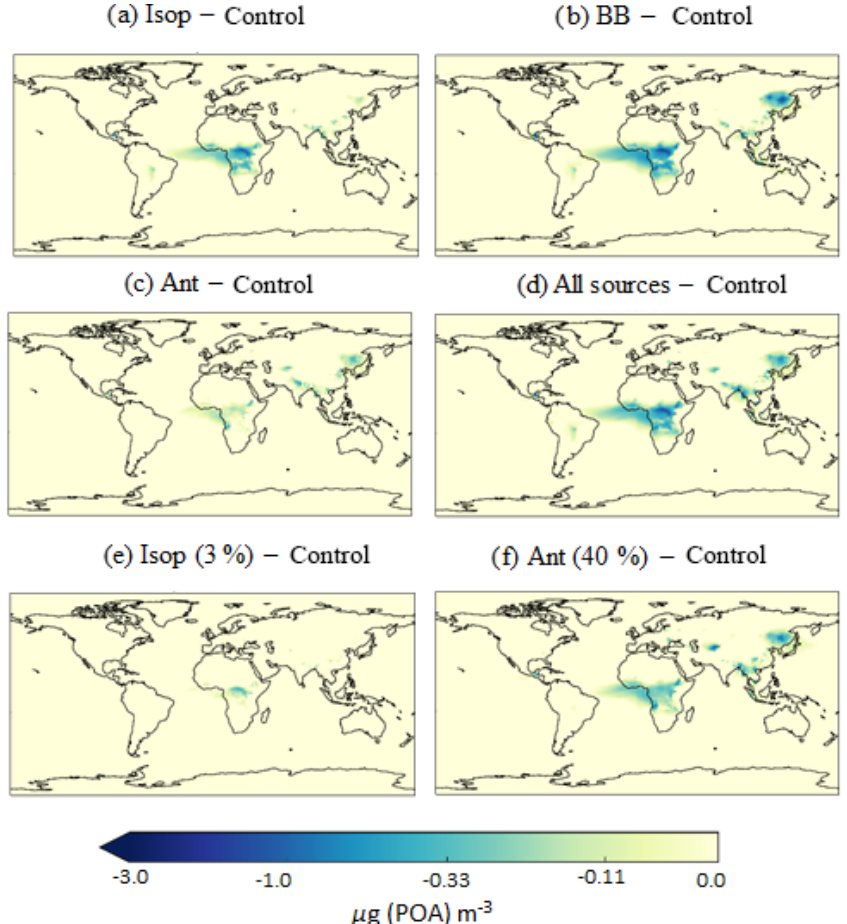
Figure 9. Differences in annual average surface total POA concentrations (µgm − 3 ) relative to the control run for the following simulations: (a) AllSources, (b) Iso, (c) BB, and (d) Ant, which are described in Table 2. Regions of decreased POA correspond to regions of increased SOA concentrations, availability of hydrophobic POA and efficient wet